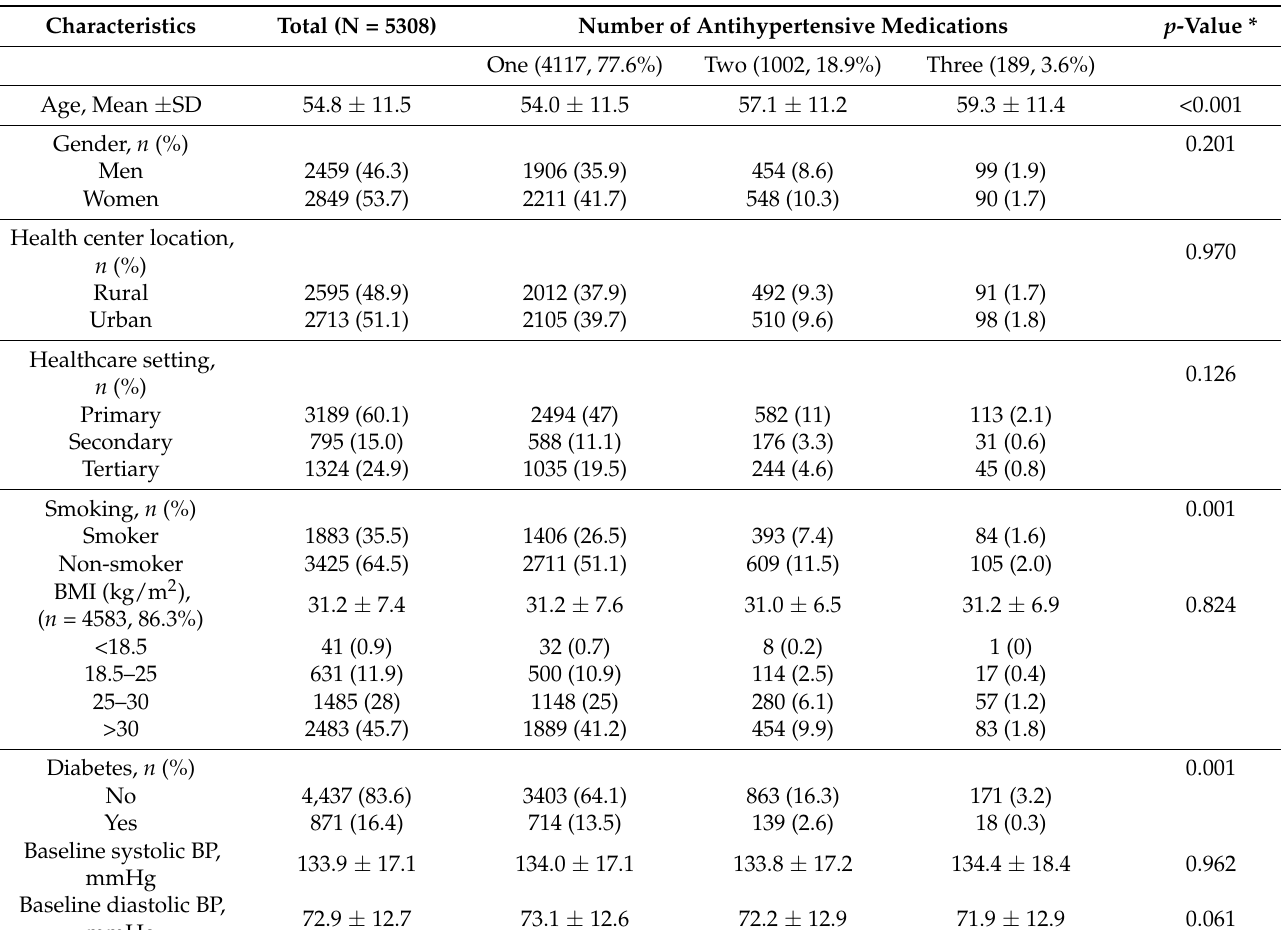
Table 1. Clinical characteristics of study cohort with number of antihypertensive medications given at baseline. Characteristics Total (N =